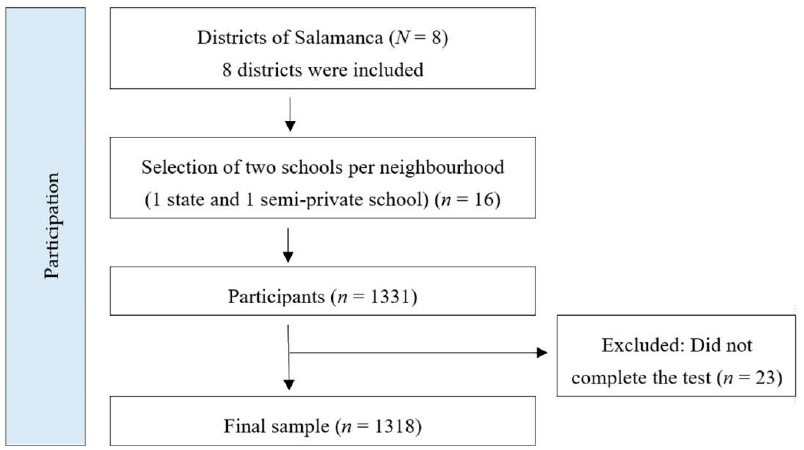
Figure 1. CONSORT chart for sampling selection.